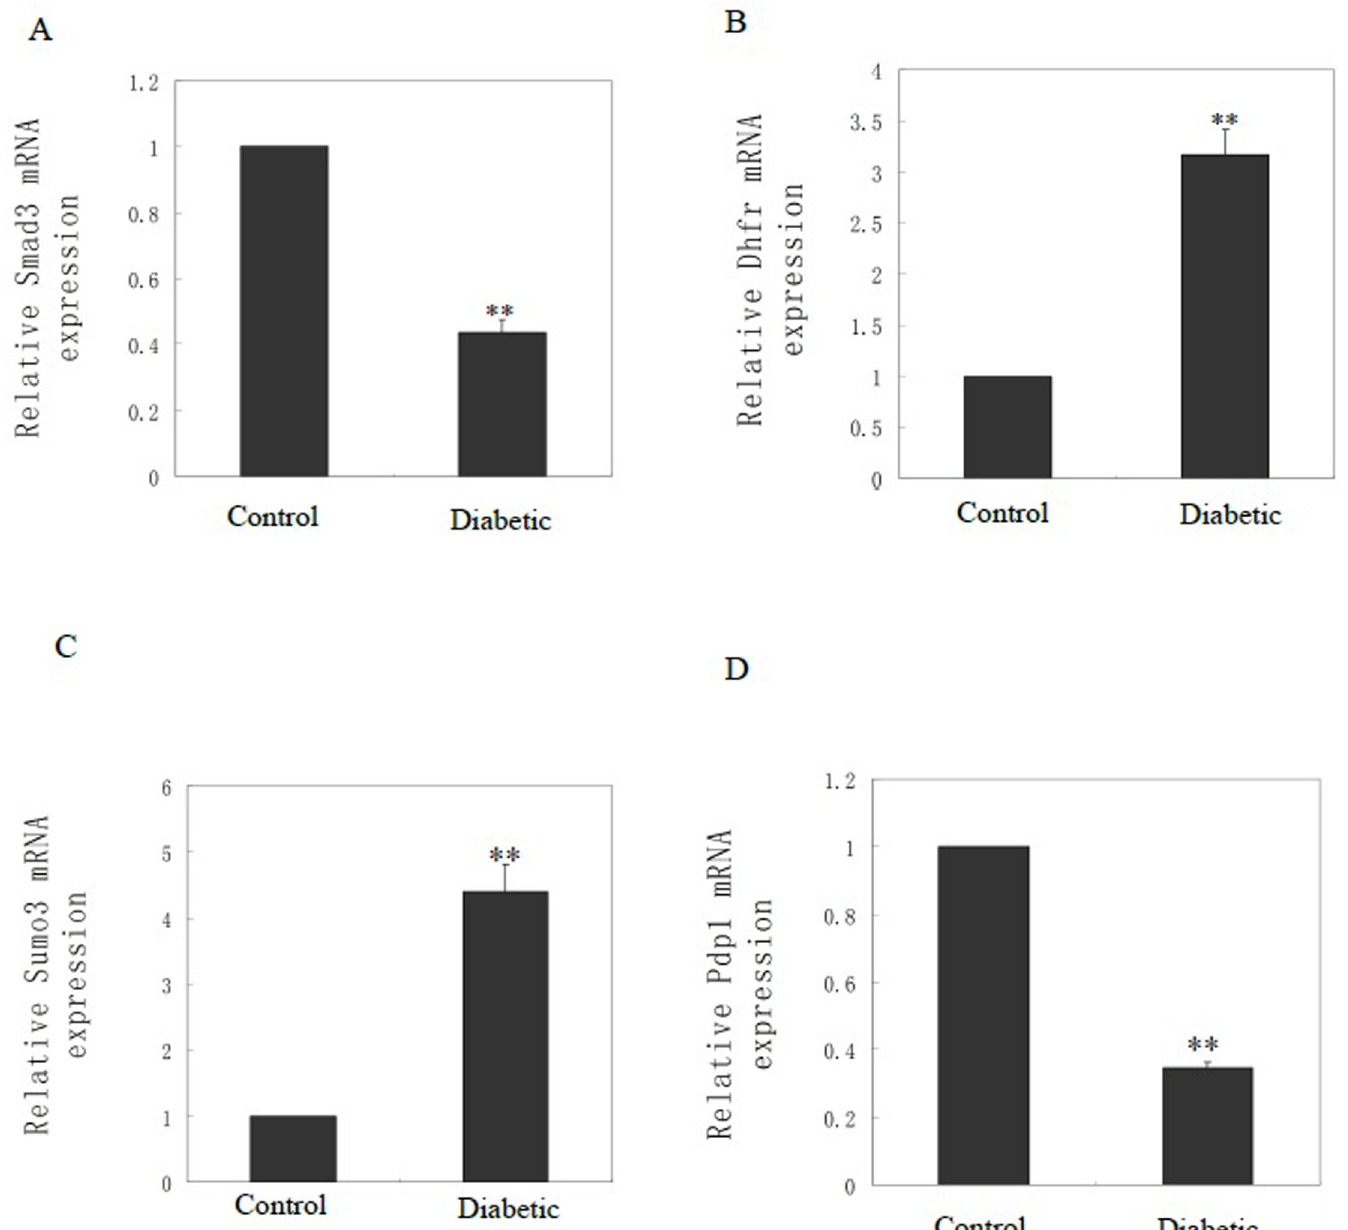
Fig 5. Genes with abnormal methylation in the upstream region differentially expressed in the diabetic and control groups. qRT-PCR was used to analyze mRNA expression of Smad3 (A), Dhfr (B), Sumo3 (C) and Pdp1 (D) in fetal heart samples from normal controls (n = 6) and diabetic (n = 6). β -actin was used as the internal reference. �� P -value <